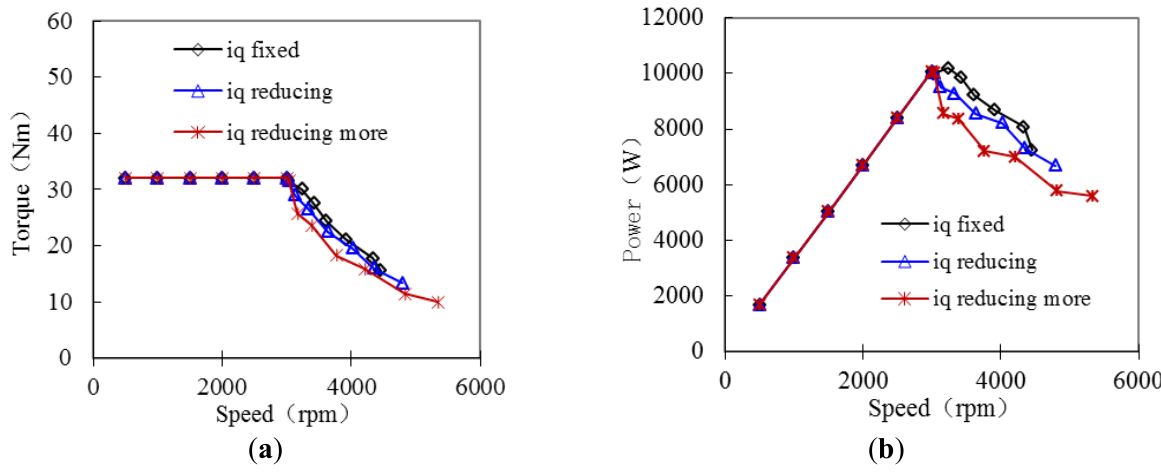
Figure 18. Field weakening results with only i